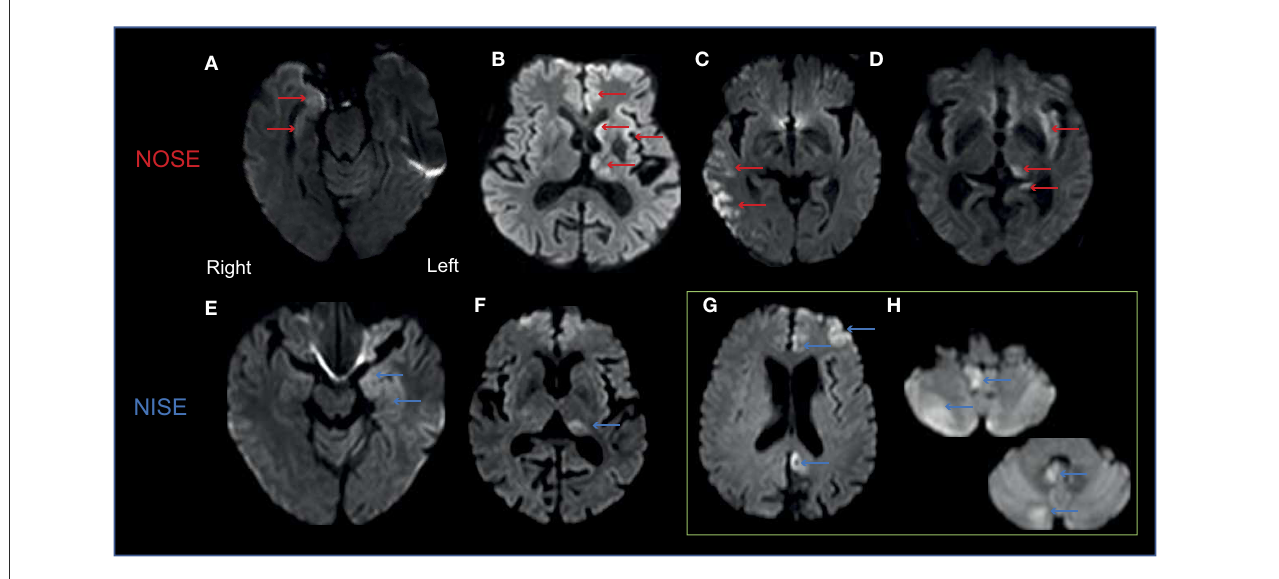
FIGURE4 Generally similar patterns of PMA in NOSE and NISE. Examples of axial DWI views in 4 patients. (A) Right medial temporal hyperintensity in an 86-year-old woman with focal convulsive refractory NOSE. (B) Left thalamic, caudate nucleus, and frontal cortex hyperintensities in a 56-year-old man with generalized convulsive secondary non-convulsive super-refractory NOSE. (C) Right temporo-parietal cortex hyperintensity in a 79-year-old man with refractory generalized convulsive secondary non-convulsive NOSE. (D) Claustrum hyperintensity in the left hemisphere associated with a homolateral pulvinar and hippocampal hyperintensity in a 69-year-old alcoholic male with pharmacosensitive non-convulsive NOSE (SESA). (E) Left medial temporal hyperintensity in a 48-year-old man with pharmacosensitive focal non-convulsive NISE. (F) Left pulvinar hyperintensity in a 70-year-old man with pharmacosensitive focal non-convulsive NISE. (G, H) Right cerebellum hyperintensity and contralateral cortical hyperintensity in a 63-year-old man with a non-convulsive super-refractory